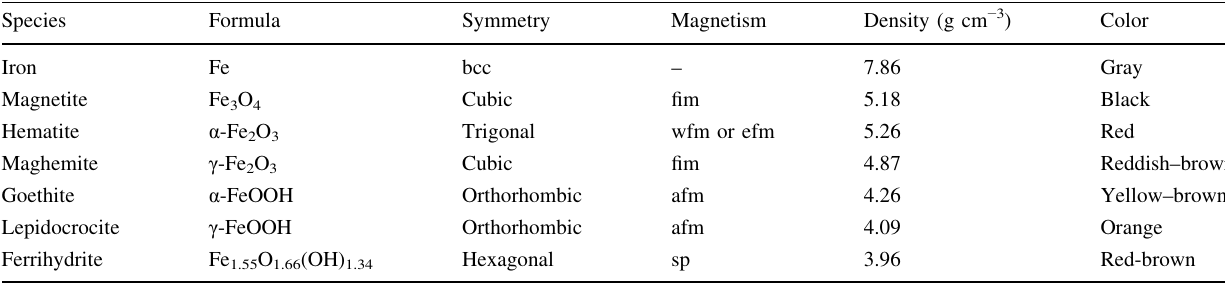
Table 2 Selected physical and chemical characteristics of some iron minerals relevant for environmental Fe 0 /H 2 O systems